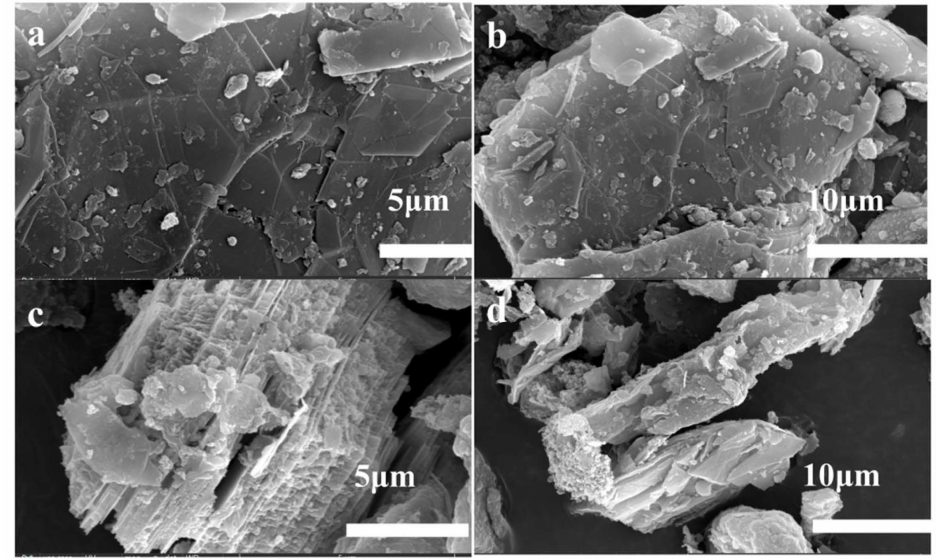
Figure 7. SEM images of ( a , b ) mixed material before leaching and ( c , d ) black leaching